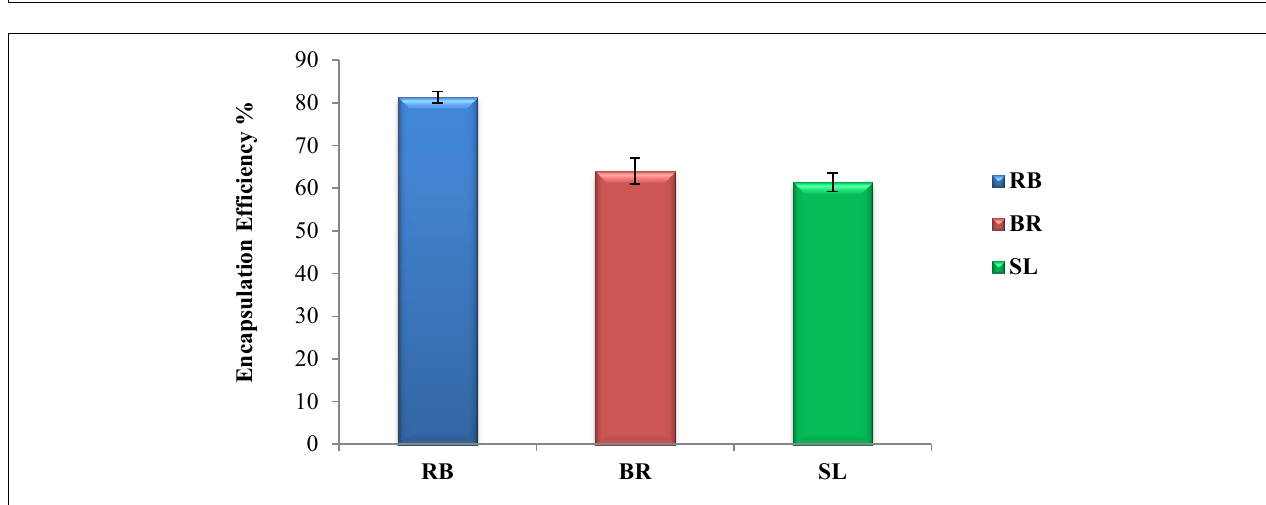
FIGURE 2 | Encapsulation efficiency (EE %) of the red beet (RB), broccoli (BR), and spinach leaf (SL) complex coacervate microcapsules.